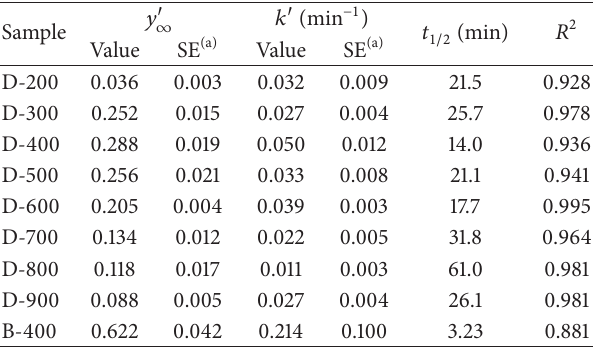
Table 3: Parameters of the pseudo-first-order kinetic model describing the 2,4,5-TCP